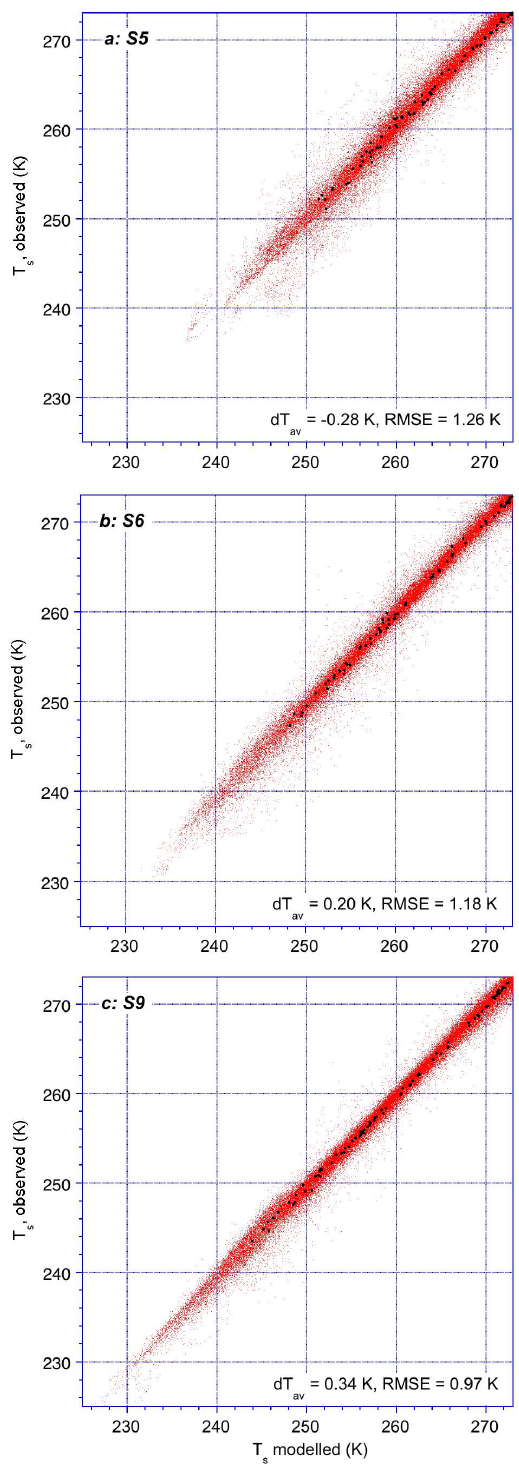
Fig. 3. Observed vs modelled surface temperature for hourly (red dots) and monthly averages (black dots) at S5 (a) , S6 (b) and S9 (c) . dT av is average difference, RMSE is Root Mean Squared